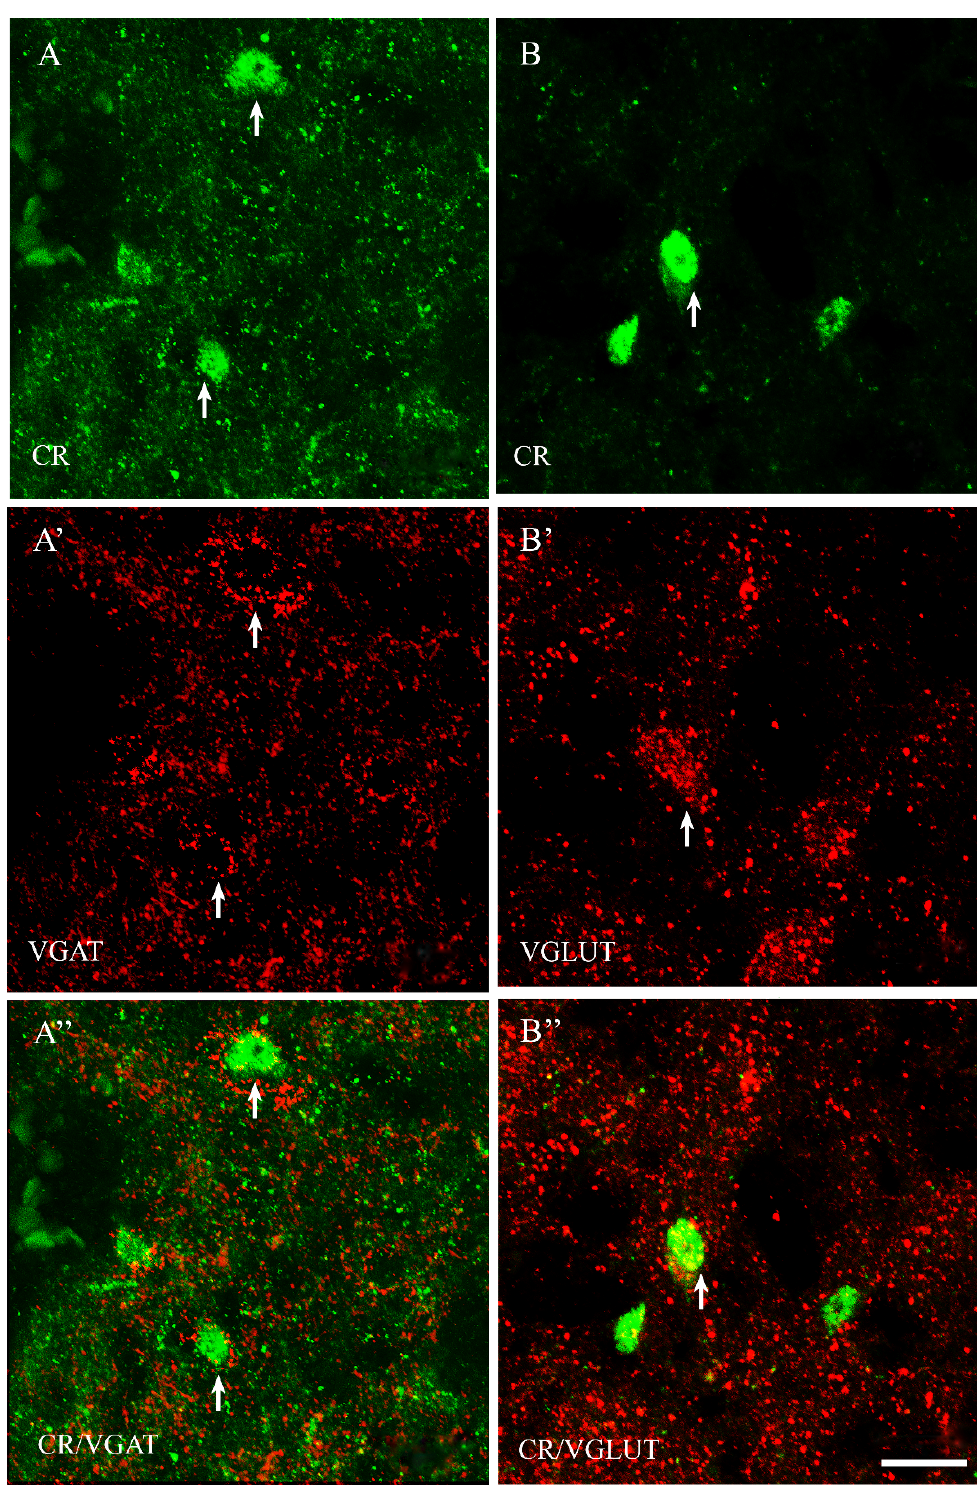
Figure 4. Double-labeling confocal immunofluorescence illustrating the anatomical relationships between CR+ neurons and VGAT ( A – A” ) as well as CR+ neurons and VGLUT ( B – B” ) in the median preoptic nucleus of the guinea pig. Arrows show CR+ neurons that were simultaneously VGAT+ ( A – A” ) and/or VGLUT+ ( B – B” ). Scale bar = 20 μ m.